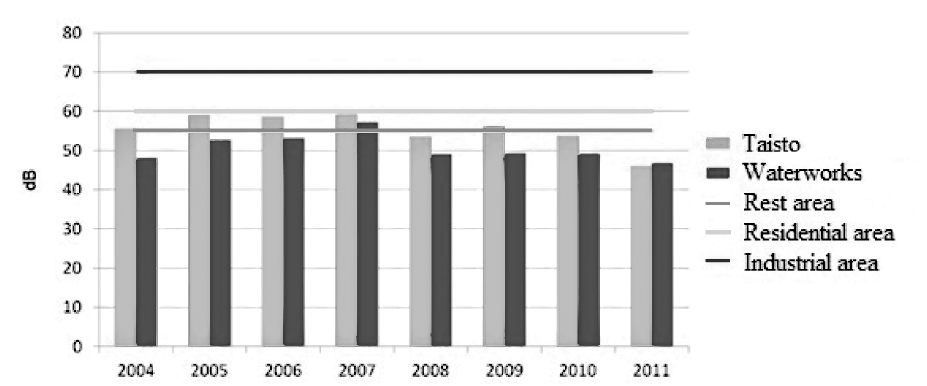
Fig. 3. Average daytime noise indicators at Tallinn Airport in 2004–2011 compared to noise limits established in various areas (Keskküla